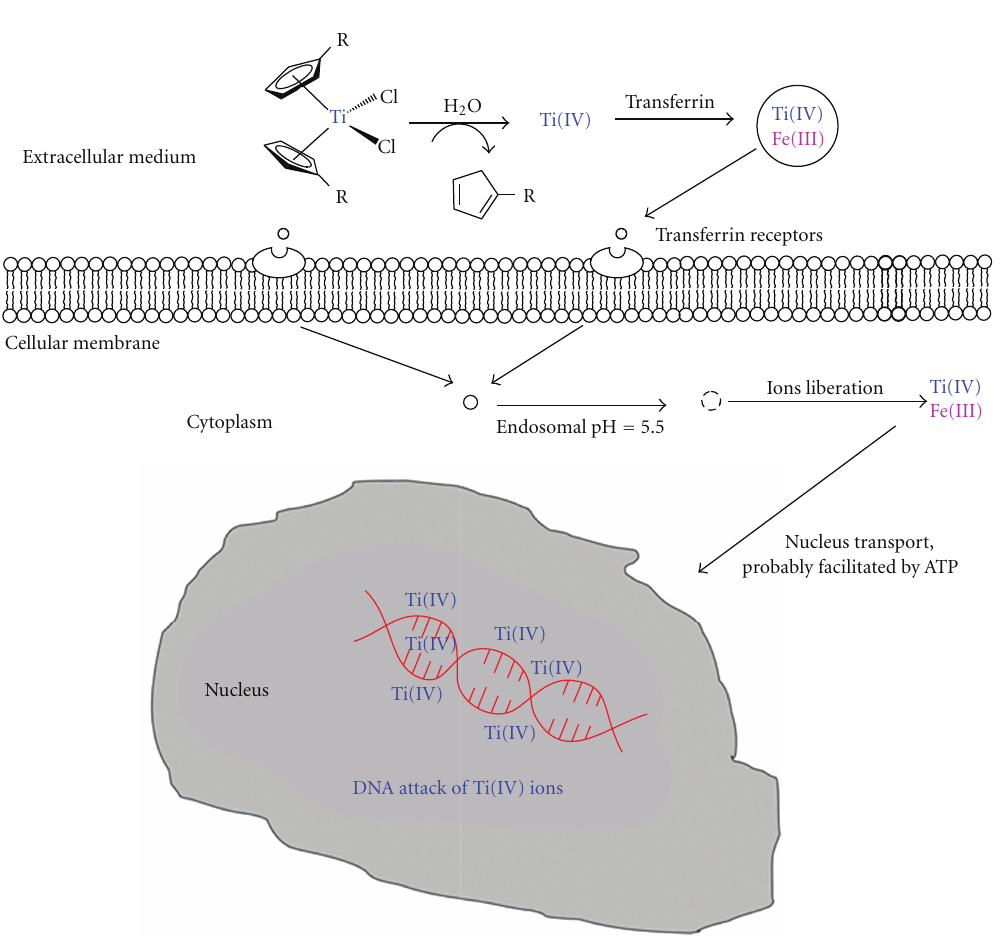
Figure 6: Proposed mechanism of action of titanocene derivatives (adapted from Abeysinghe and Harding, Dalton Trans. 32 (2007) 3474).